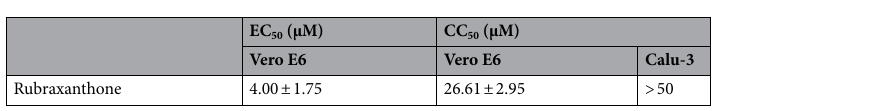
Table 1. Rubraxanthone efficacy, as determined using cell-based assays. Results are presented as mean ± standard error of the mean (SEM) for three biologically independent